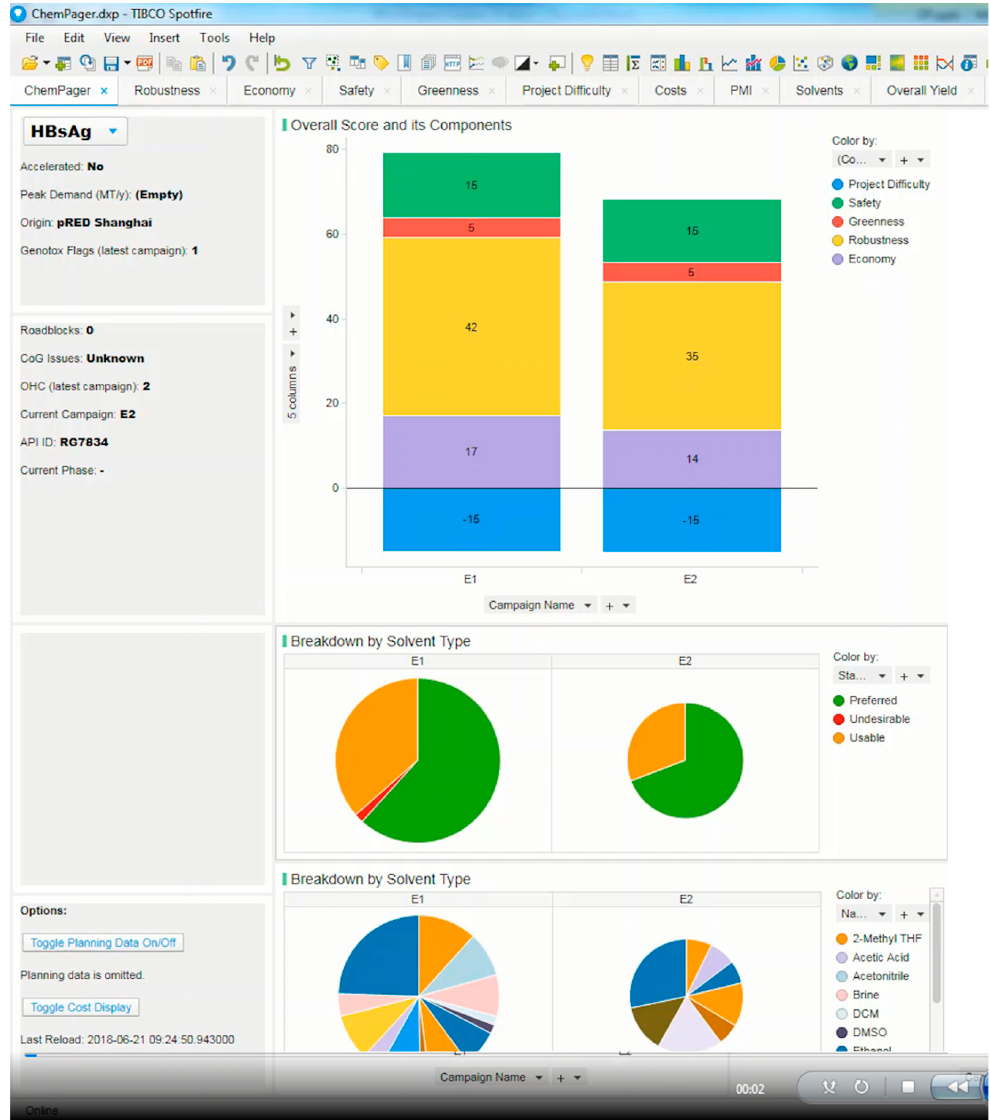
Figure 8. Example of page in ChemPager, partial view. Adapted from Refs.